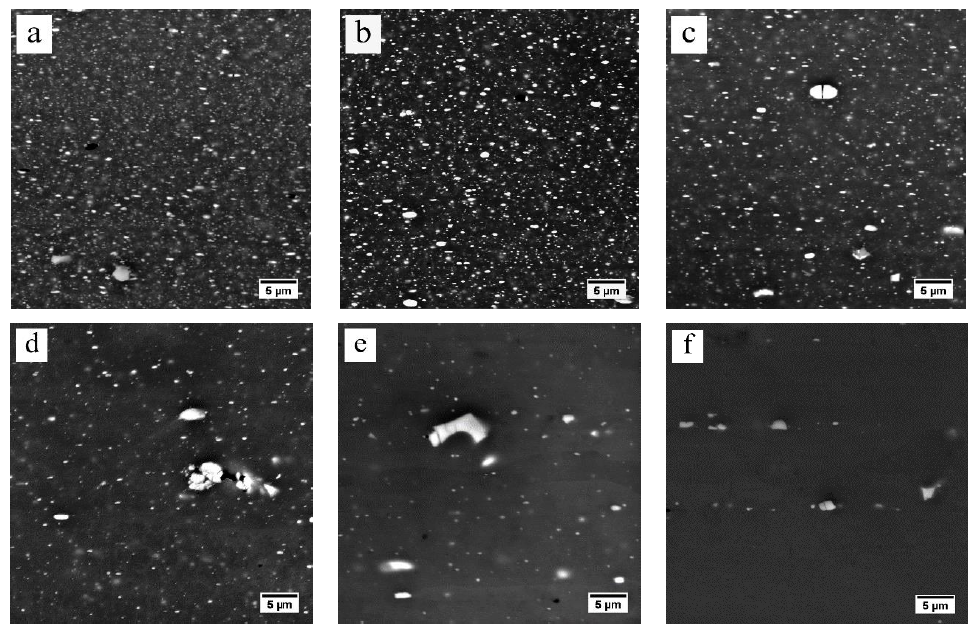
Figure 7. The SEM-BSE images of fast-heated samples quenched at ( a ) 300 °C, ( b ) 350 °C, ( c ) 400 °C, ( d ) 450 °C, ( e ) 475 °C and ( f ) 475 °C for 1 h.